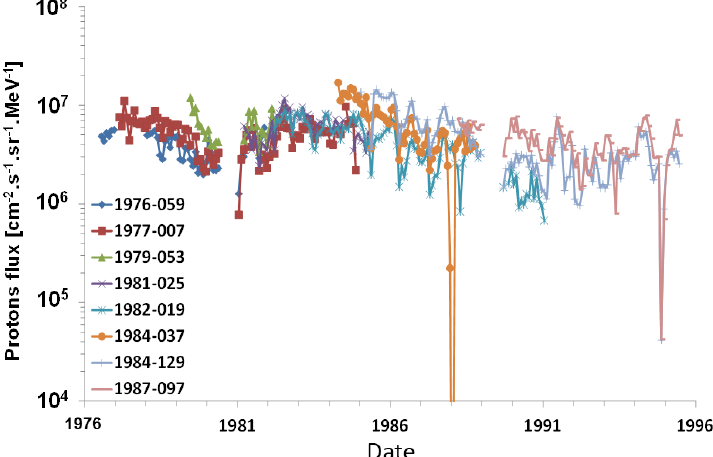
Figure 11. Monthly average 80keV proton flux measured in GEO by the detector CPA-LoP on board the different LANL